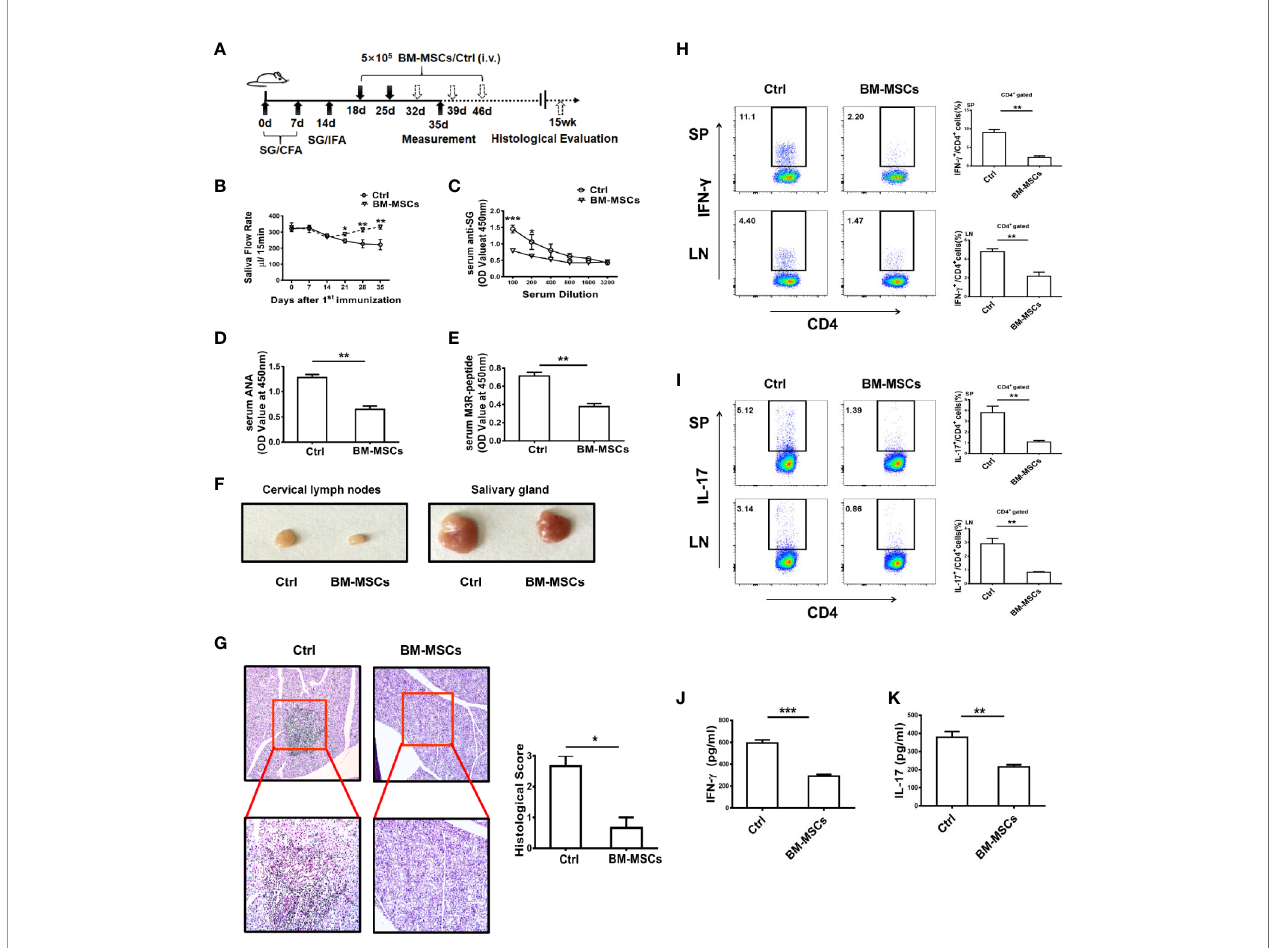
FIGURE 1 | BM-MSCs suppress the progression of ESS. (A) Graphic scheme of ESS induction and BM-MSCs administration. C57BL/6 mice were immunized with SG/CFA on days 0 and 7, and mice were boosted with SG/IFA on day 14. Treatment groups were intravenously injected with 5×10 5 BM-MSCs on days 18 and 25. Mice were sacri fi ced on day 35 (n=6). (B) The saliva fl ow rates were measured in each group. (C – E) Autoantibodies against SG antigens (C) , ANA (D), and anti-M3R antibodies (E) were detected in the serum of ESS mice on day 35. (F) Representative graphs show the sizes of CLN and SG. (G) ESS mice were transferred with BM-MSCs on days 18, 25, 32, 39 and 46, the histological evaluation of glandular destruction in each group was performed on tissue sections of submandibular glands with H&E staining 15 weeks post fi rst immunization. (H, I) Both proportions and numbers of CD4 + IFN- g + Th1 cells (H) and CD4 + IL-17 + Th17 cells (I) were measured in SP and CLN of mice with different treatment on day 35. (J, K) Serum levels of IFN- g and IL-17 were detected in different groups on day 35. Data are shown as mean ± SD of three independent experiments, n=6/group. ***p < 0.001, **p < 0.01, *p <